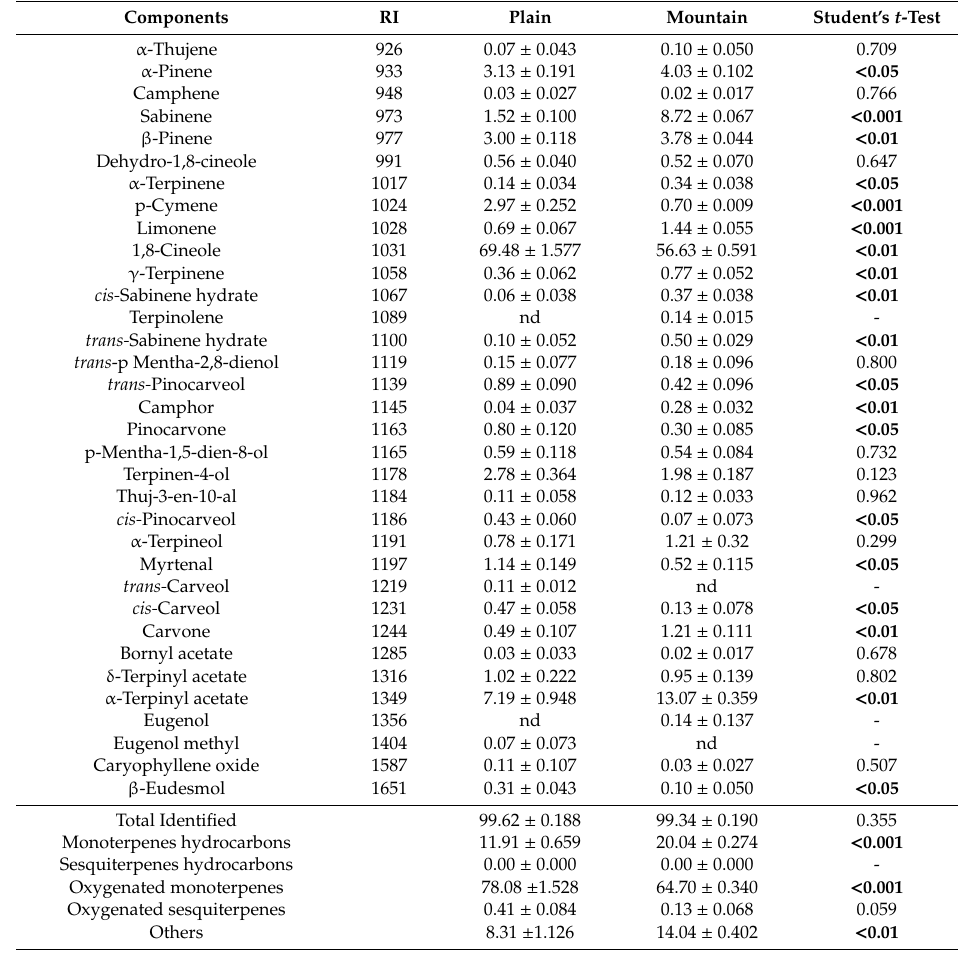
Table 4. Chemical composition (%) of essential oils of laurel plants grown at di ff erent altitudes (plain vs. mountain). Data are expressed as means ± SE (n = 3), and significant di ff erences ( p < 0.05, p < 0.01, p < 0.001) in bold between treatments are indicated by Student’s t -test p